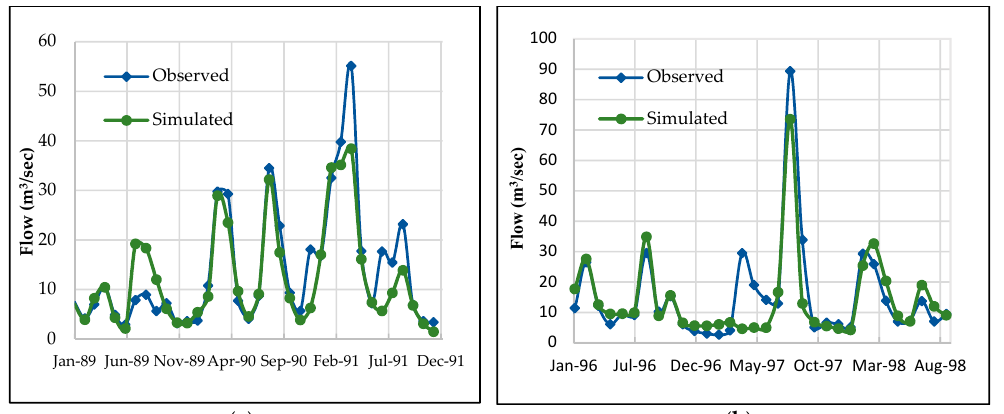
Figure 6. Observed and simulated discharge at Haro River ( a ) during the calibration period; ( b ) during validation period.